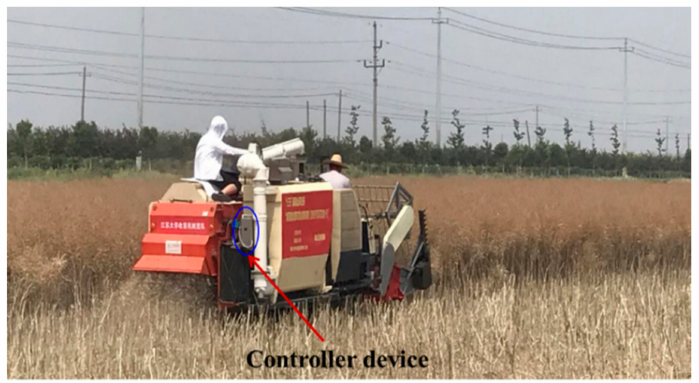
Figure 8. Field test.